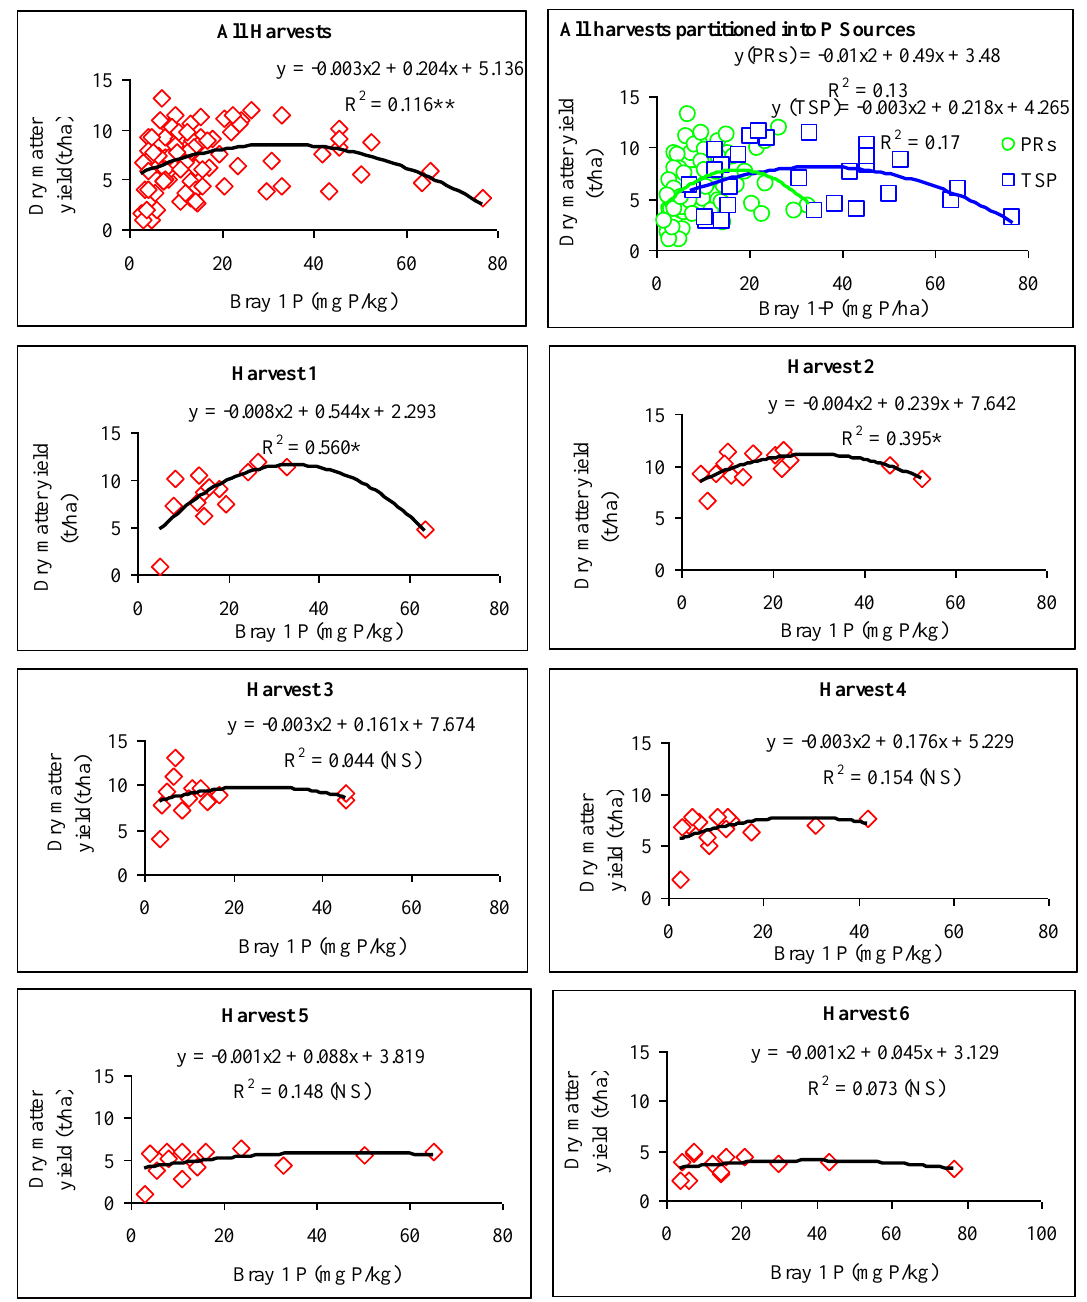
FIGURE 3A . Relationship between B1 extractable P and Setaria DMY for all harvests, all harvests partitioned into different P sources, and harvests 1–6. NB: * and ** denote significance at 5 and 1%, respectively. NS denotes not